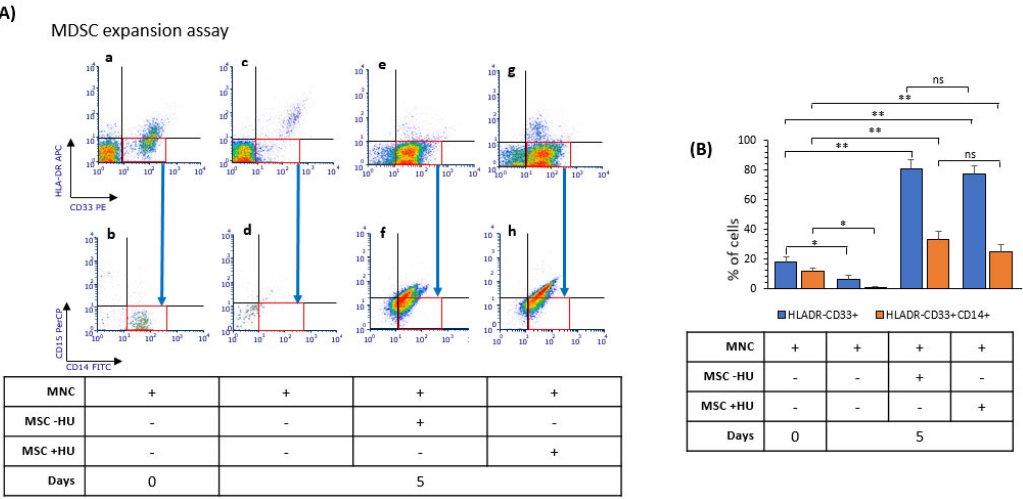
Figure 7. Hydroxyurea does not alter the capacity of BMMSC to induce monocytic myeloid-derived suppressor cells expansion. ( A ) BMMSC were pre-treated for three days with 200 µ M of HU and co-cultured with-PBMC isolated from healthy donors for five days. Then, PBMC were subjected to immunostaining for HLADR, CD33, CD14, CD15 surface antigens by flow cytometry. Gating was performed to distinguish to populations of cells HLADR-CD33+ cells and M-MDSC (HLADR-, CD33+, CD14+, CD15-) Red squares indicate the selected gating areas for quantification analysis. ( B ) Bar plot for HLADR-CD33+ cells and M-MDSC quantification. Results presented are representative from at least 3 performed experiments. Significant difference control cells by t -test: p < 0.05 (*) and p < 0.005 (**).